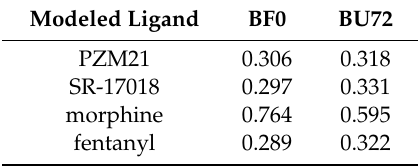
Table 3. Tanimoto coe ffi cient values between the co-crystallized ligands and the examined compounds. Modeled Ligand